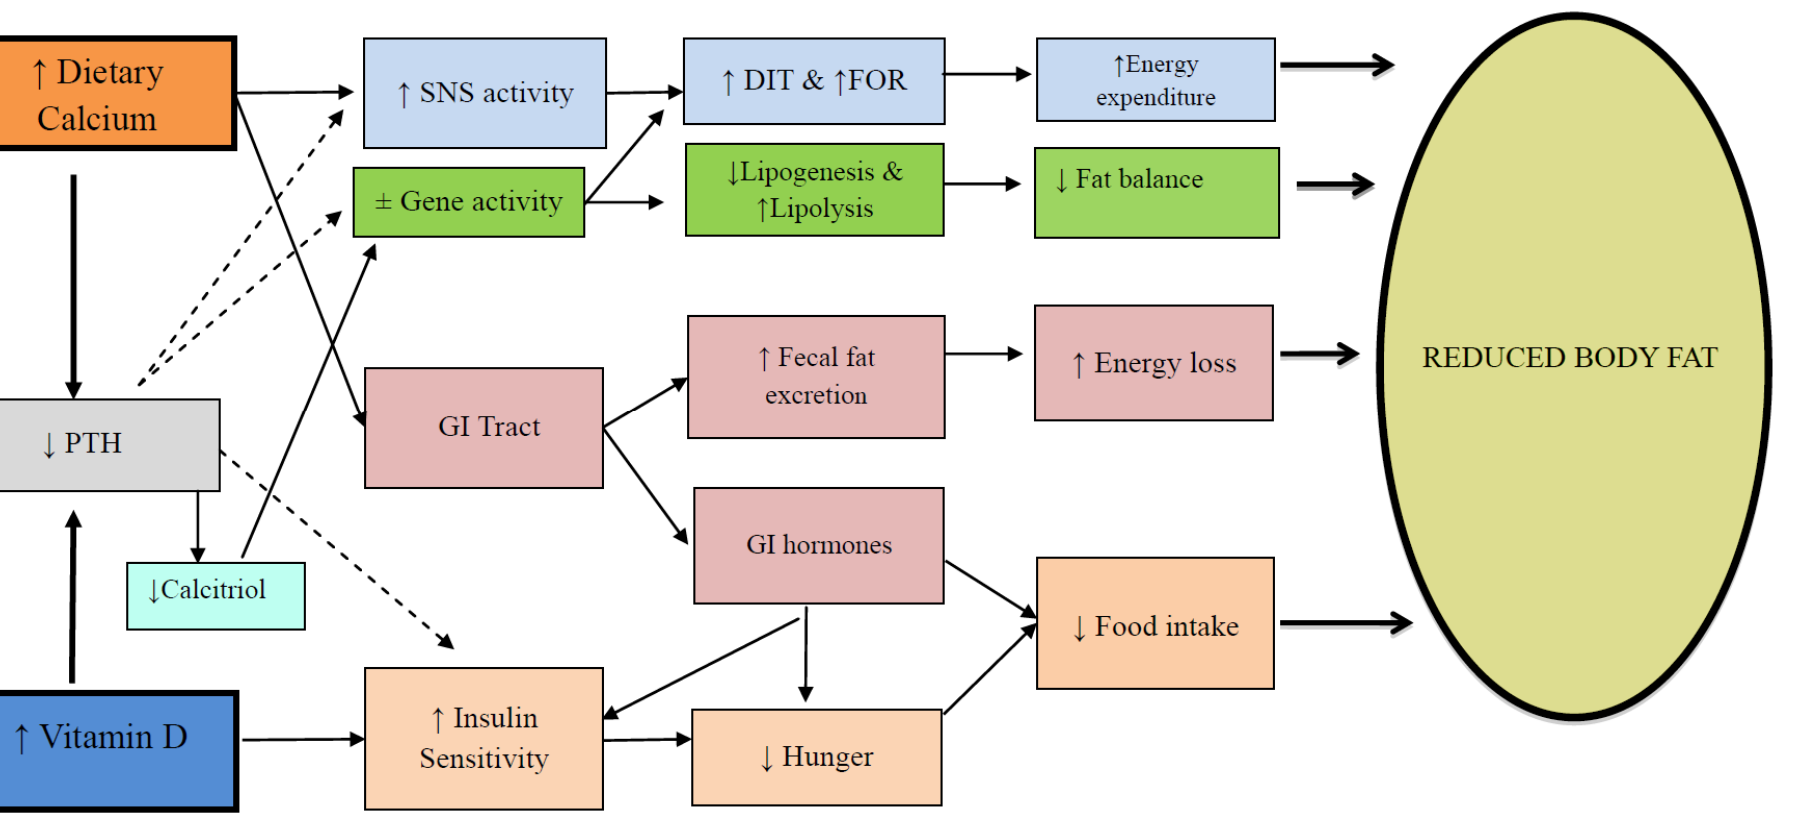
Figure 1. The modulation of energy balance by calcium and vitamin D. ↑ = increased, ↓ = decreased, PTH = parathyroid hormone, Calcitriol = 1,25(OH )D, SNS = sympathetic nervous system, ±Gene activity = decreased expression of genes controlling lipogenesis (usually 2 sterol regulatory element-binding protein-1, peroxisome proliferator-activated receptor gamma, fatty acid synthase) or increased expression of genes for lipolysis (lipoprotein lipase or hormone sensitive lipase) and increased thermogenesis (uncoupling protein activity), GI = gastro intestinal, DIT = diet-induced thermogenesis, FOR = fat oxidation rate. (From Soares et al. 2012 [8] with